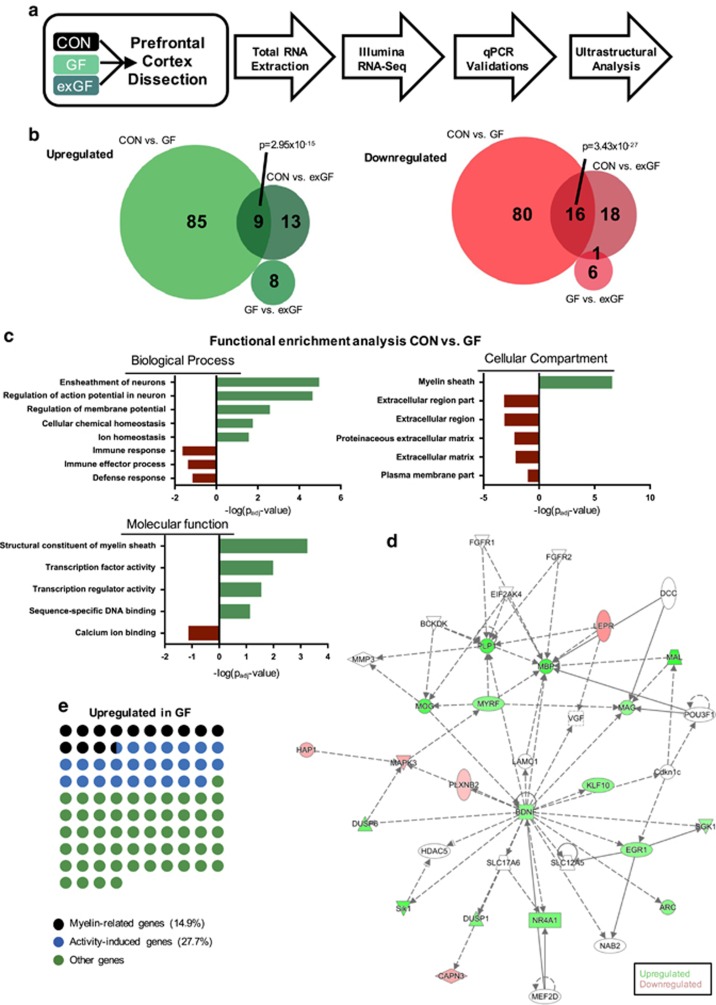
Differential gene expression in the prefrontal cortex of conventional (CON) and germ-free (GF) raised mice highlights myelin pathways to be significantly different. (a) Schematic of experimental design. (b) Venn diagrams representing overlaps of differentially expressed genes between experimental groups. A total of 236 genes were found to be different between groups. P-values indicate significant overlaps as determined by Fisher's exact test. (c) Functional enrichment analysis revealed significantly enriched Gene Ontology terms in GF condition associated with myelin sheath formation and regulation of action potentials amongst upregulated genes. Enrichment of downregulated genes highlights immune and defence mechanisms. (d) Gene network representing interactions and upstream regulators of genes affected in GF mice compared with CON mice. Network highlights interactions of upstream transcription factors regulating myelin component genes. (e) Fractions of upregulated genes in GF that are known to regulate myelination or are myelin component genes. Each dot represents one of 94 genes upregulated in GF mice.